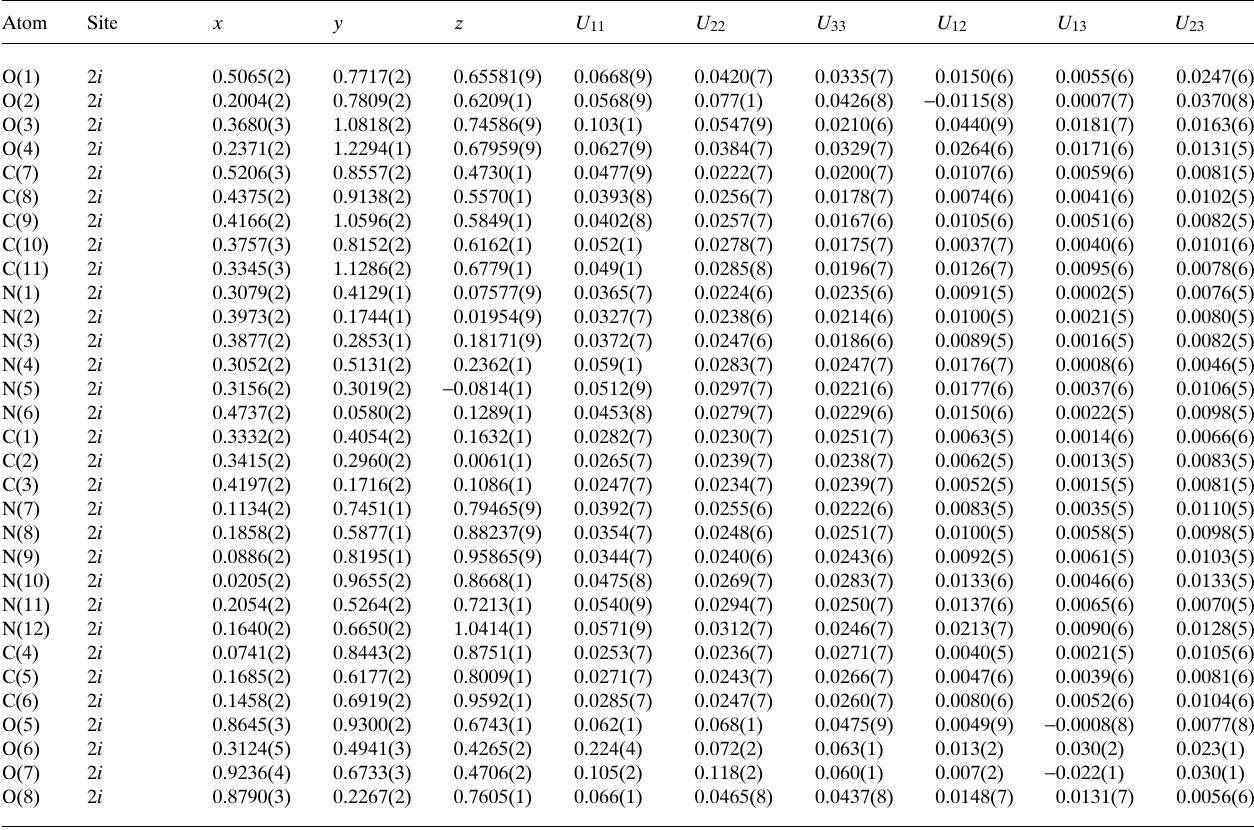
Table 3. Atomic coordinates and displacement parameters (in Å 2 ) .